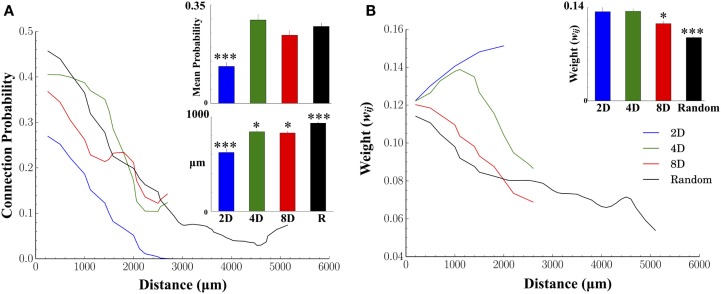
Structural connectivity relative to physical distance and connection weights between nodes. In both human and animals, connectivity is often constrained by biology to be distributed across finite distances where the probability of forming connections decreases the more distant the postsynaptic target is. (A) As expected, we found significantly fewer connections were formed with increasing physical distance for each network topology. In the 2D topology, mean connection probabilities were significantly lower than other topologies. Unlike other groups, in the 2D topology, connectivity was forced to travel along a straight line. Typical connection distances of those connections (for connections less than 2500 μm for comparison among groups) were significantly higher in Random, 4D and 8D, relative to 2D. (B) Connection weights were also weaker for connections at increasing distance. The largest weights were found in 2D networks followed by 4D, 8D, and finally Random topologies (inset upper right) while the distribution of weights (lower left) appear exponential irrespective of topology.